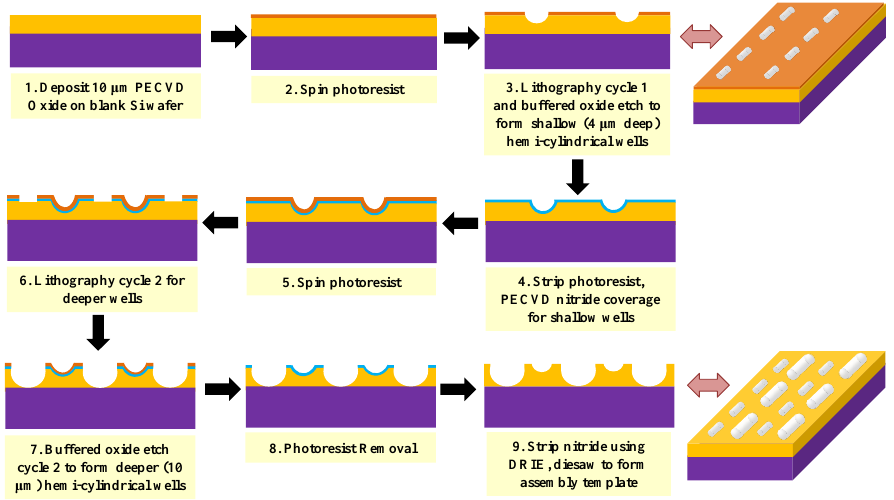
Figure 2. Schematic diagrams of the fabrication of the substrate. A plasma enhanced chemical vapour deposition (PECVD) silicon dioxide layer is deposited on a silicon substrate and patterned with photoresist. The oxide is isotropically etched with buffered oxide etch (BOE) through the patterned mask to form the first set of nearly hemicylindrical assembly wells. A layer of PECVD silicon nitride is deposited to protect the first set of wells during the subsequent processing and is patterned to expose the locations where the second set of wells will be created. The second set of features is lithographically patterned in a layer of photoresist, and wells are isotropically etched from the second set of features. The silicon nitride is removed, and the individual dies are